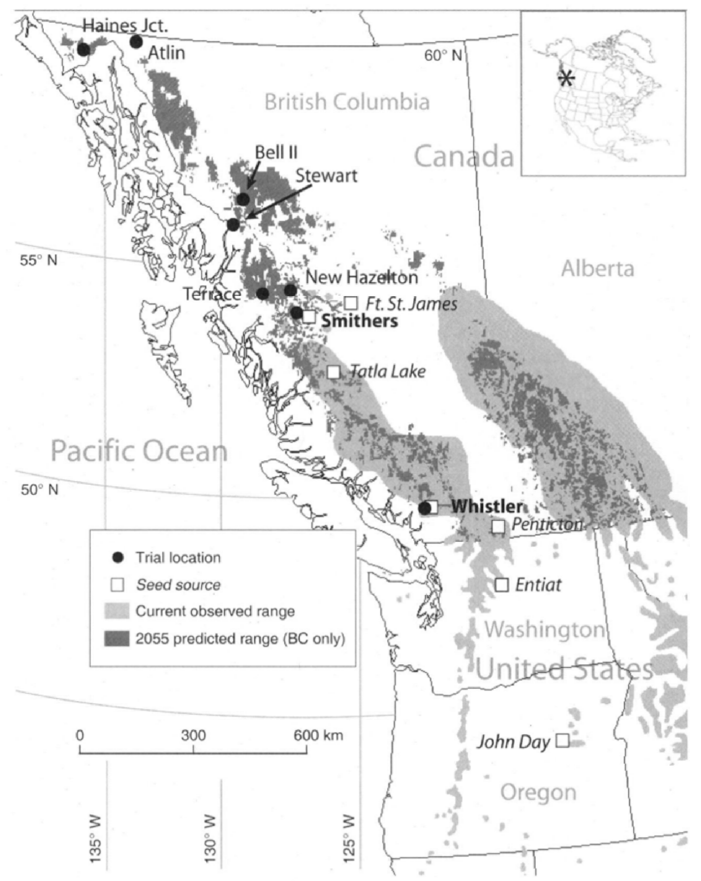
Figure 1. Location of Pinus albicaulis provenances and common garden locations for the assisted migration experiment, with current and 2055 predicted Pinus albicaulis ranges shown (from [53]). Briefly, seed from six provenances of Pinus albicaulis was directly sown into common gardens in eight subalpine locations in BC, including sites within the current species range, sites north of the range predicted to be climatically suitable in 2055, and sites north of the species range predicted to be unsuitable in 2055 (Figure 1). Seeds rather than seedlings were sown to test whether sites were within the species ecological niche without circumventing life history stages. Half the seeds planted were extracted from cones and sown in fall 2007, untreated, while half were subject to a maturation and dormancy-breaking treatment, then collected in 2008, 2009, 2010 (see [53]), and in 2017 (Reid, McLane, Chourmouzis and